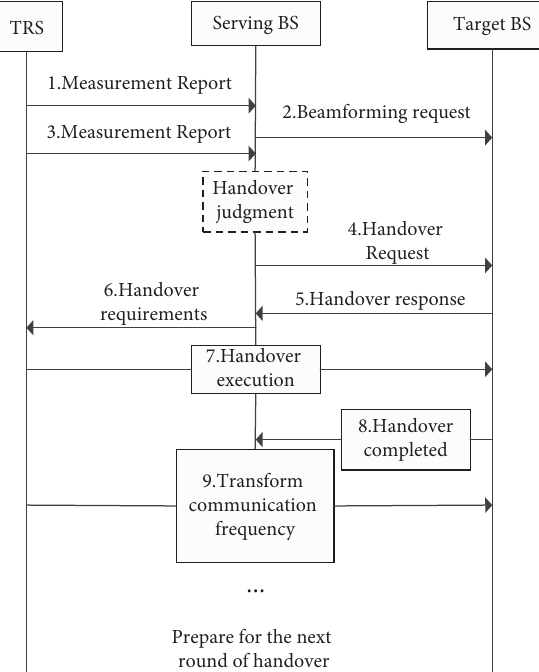
Figure 3: Handover scheme based on